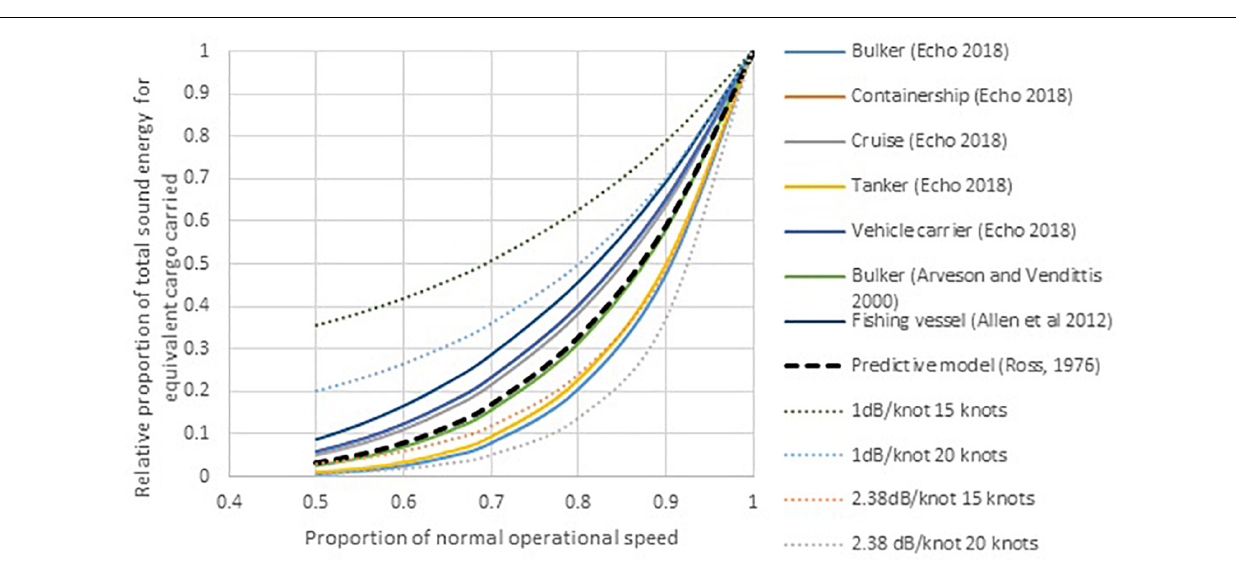
FIGURE 3 | Relative proportion of total sound energy [also equivalent to the relative total acoustic footprint as defined by Leaper et al. (2014)] from a number of studies. Dotted lines indicate relationships that are dependent on the initial speed. The dashed line indicates z = 6 in Eq.